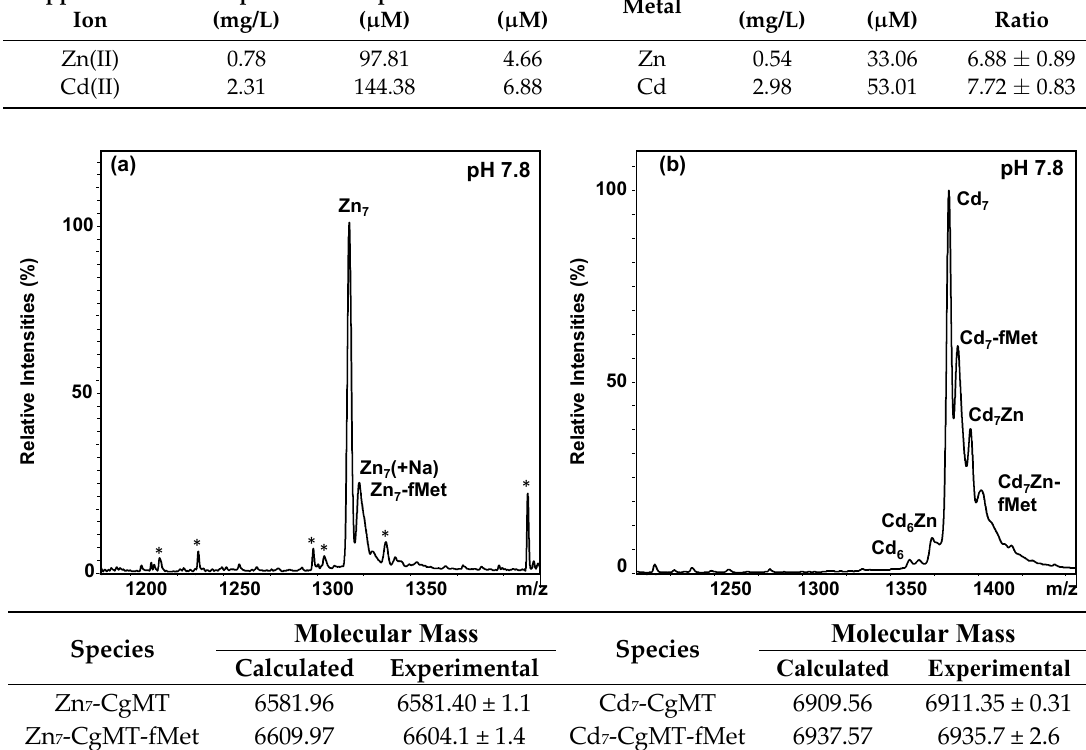
Figure 4. The most abundant +5 charge state of representative ESI-MS spectra of: ( a ) Zn(II)-CgMT; or ( b ) Cd(II)-CgMT (10 mM NH 4 HCO 3 , 10% MeOH) at native pH. The relatively large errors for the experimental masses for the fMet species are due to its low abundance and overlap with a sodium adduct that cannot be resolved for the metal-containing species due to their broad isotopic distributions. Peaks marked with an asterisk (*) indicate impurities.